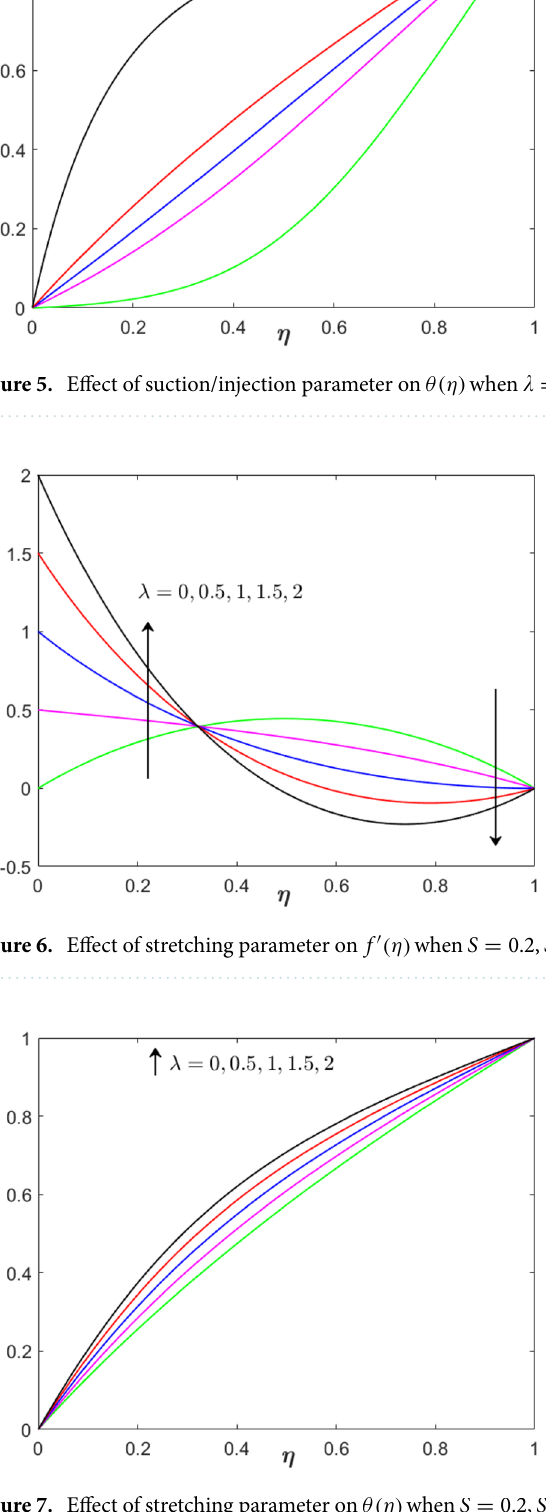
Figure 7. Effect of stretching parameter on θ(η) when S = 0.2 , Sq = M = 1 and φ 1 = φ 2 = 0.01